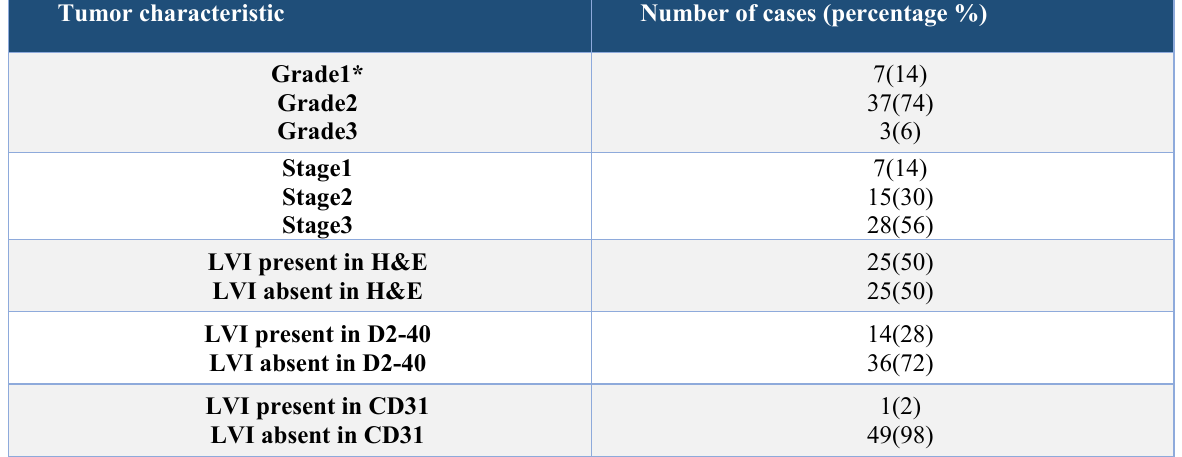
Table 1. Clinicopathological characteristics of the cases Tumor